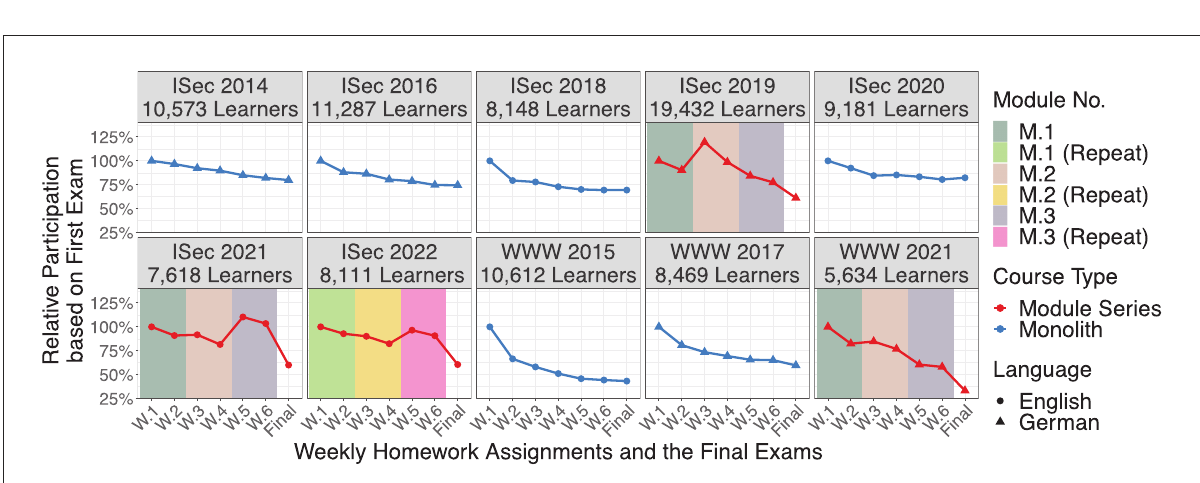
FIGURE7 Development of the participation in course assignments over the course period in relation to the participation in the homework assignment of the first week.